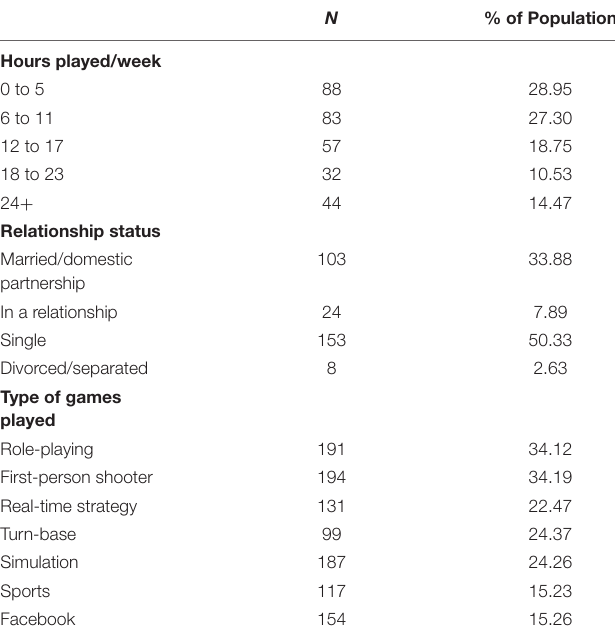
TABLE 1 | Demographic information of video gaming participants ( N =